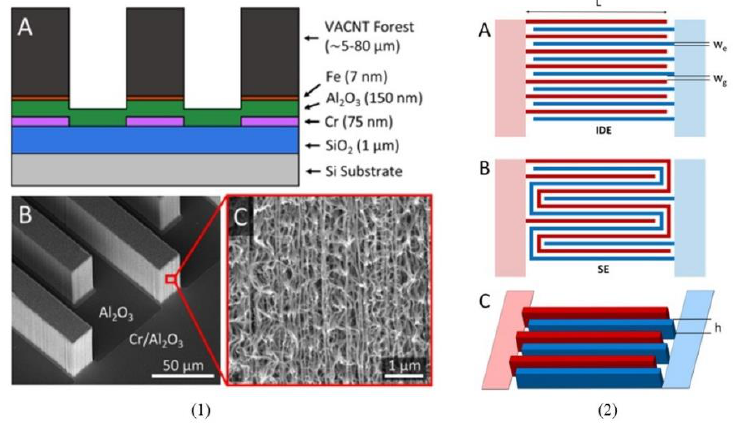
Figure 9. (1) ( A ) Schematic of layers used to fabricate the VACNT sensor architecture: Si, SiO 2 , Cr, Al 2 O 3 , Fe, and VACNTs; ( B ) scanning electron microscopy (SEM) images of 3D VACNT electrodes; and ( C ) magnified VACNTs, showing the porous nature of an electrode. (2) Schematic of the: ( A ) IDE; and ( B ) SE electrode arrangements with electrode length (L), electrode width (we), and gap width (wg) represented. Red and blue distinguish the different electrodes in the sensor, with the dark colors representing regions of VACNTs and light colors representing Cr leads under Al 2 O 3 . ( C ) Schematic emphasizing the 3D nature of VACNT IDEA electrodes with electrode height (h) represented. Reprinted with permission from [136]. Copyright © 2022 , American Chemical Society.